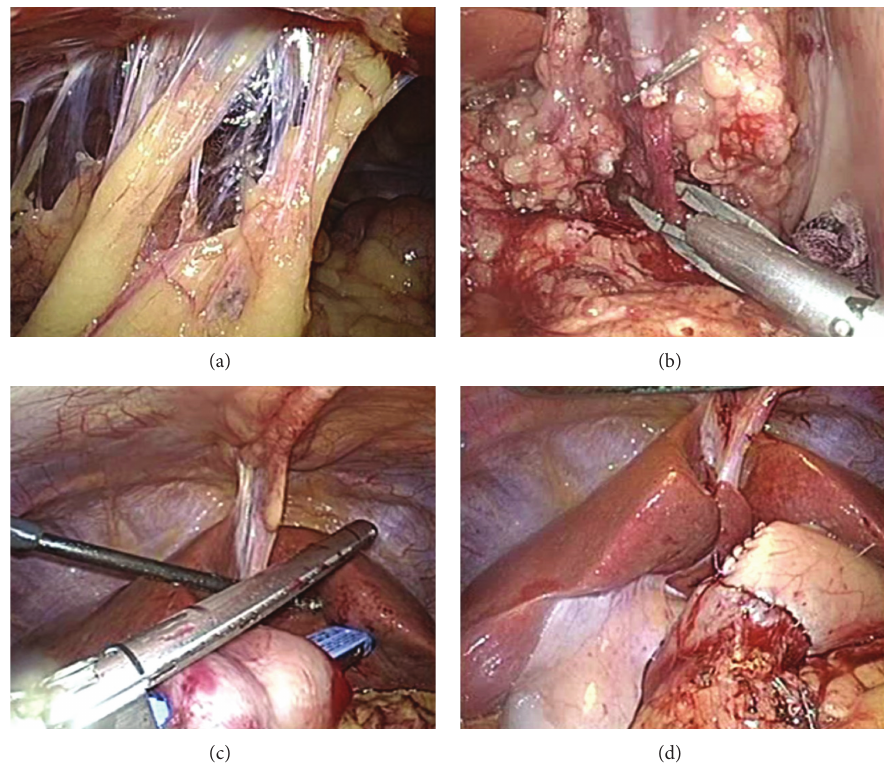
Figure 2: Intra-abdominal findings during laparoscopy-assisted distal gastrectomy with lymphadenectomy. (a) There was minimal adhesion of the omentum at the umbilical port site. (b) Dissection of lymph node stations 7 (lymph nodes along the trunk of left gastric artery). (c) Transection of the duodenum: the duodenum was cut nearly distal to the pylorus using an endoscopic liner stapler (GIA stapling system, blue; Covidien, Tokyo, Japan). (d) Billroth I reconstruction was performed by a hemi-double-stapling technique using circular stapler (DST Series EEA Stapler 28; Covidien